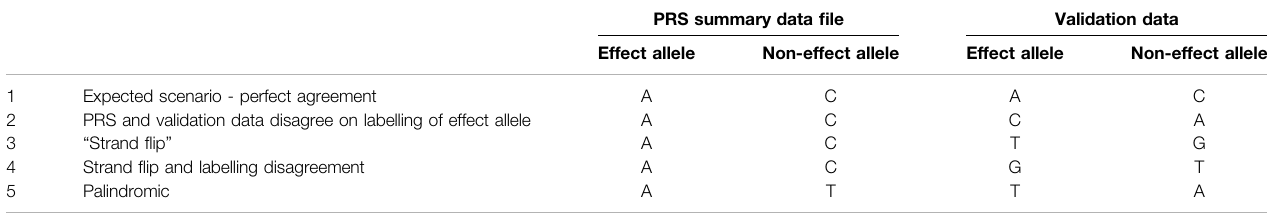
TABLE 4| FiveexamplesofpossibledisagreementsbetweenPRSand validation data,when dataharmonisation mayberequired.Weillustrate fi vedifferentsituationsinthe table: Perfect agreement, labelling disagreement, strand fl ip, strand fl ip and labelling disagreement, palindromic (ambiguous)